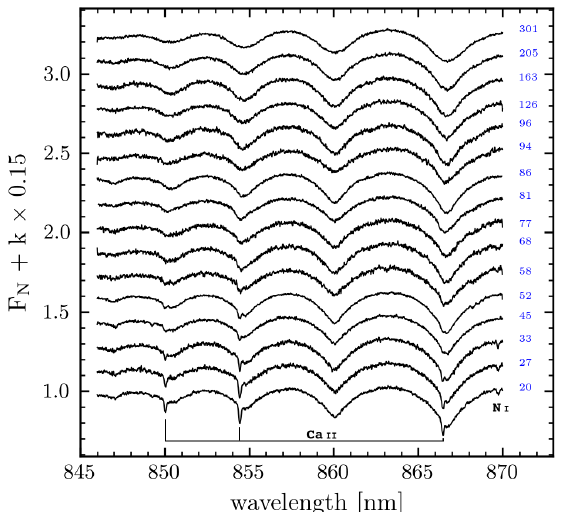
Figure 22. Variation with vsini_esphs (noted in blue, in kms − 1 ) of published Gaia DR3 RVS spectra with SNR > 200, 11,500 K ≤ teff _ esphs < 12,500 K, 3.7 ≤ logg _ esphs < 4.2. The spectra were normalized to the pseudo-continuum by the Gaia pipeline (F N ) and vertically shifted relatively to each